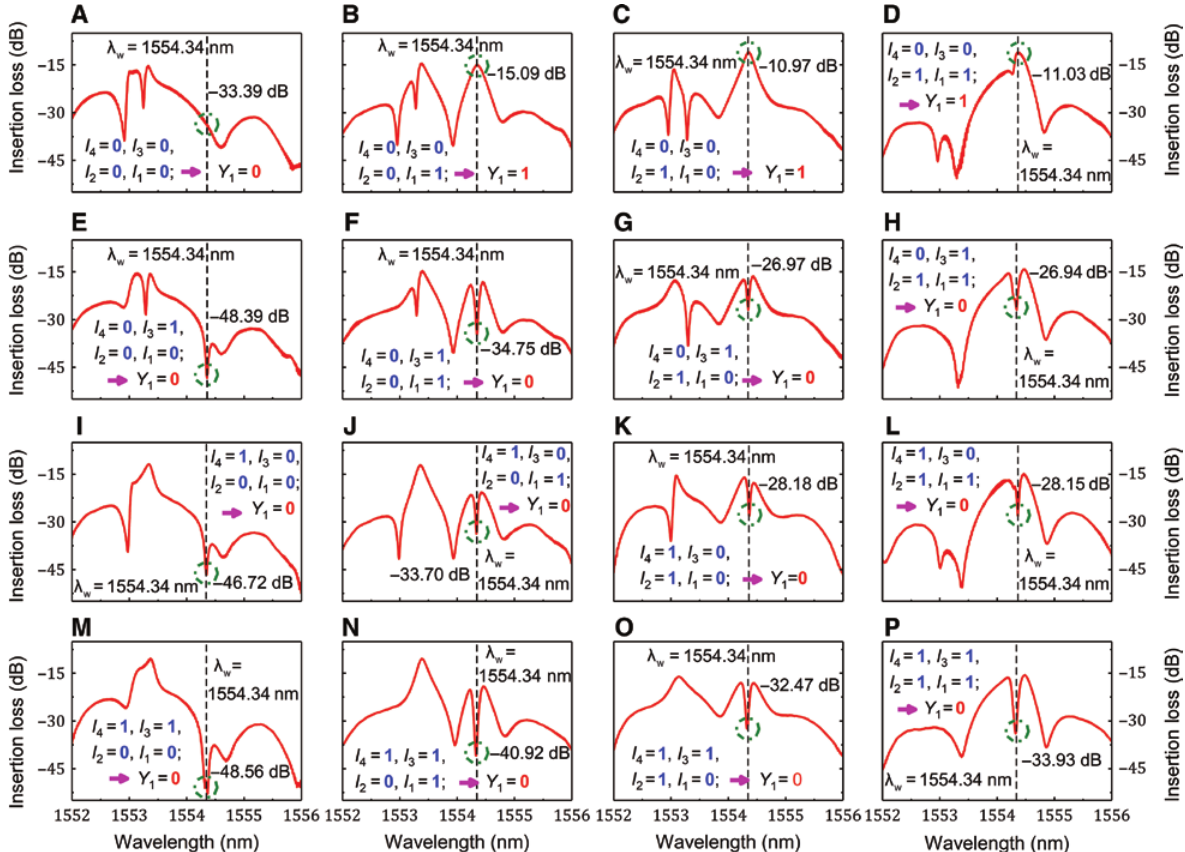
port under different combinations of 1